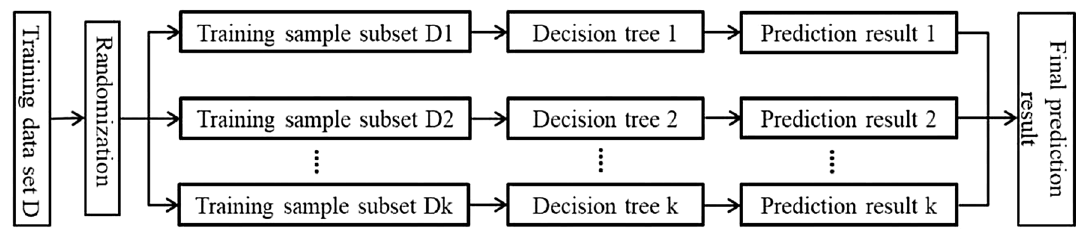
Fig. 2 Workflow diagram of a random forest ( Adapted from Wu et al.,